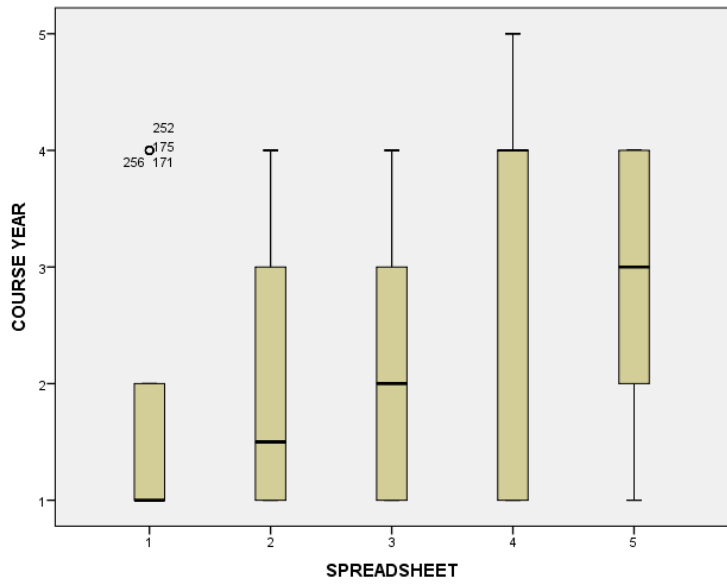
Figure 1. Box diagram. Use of the spreadsheet at a professional level depending on the course year.